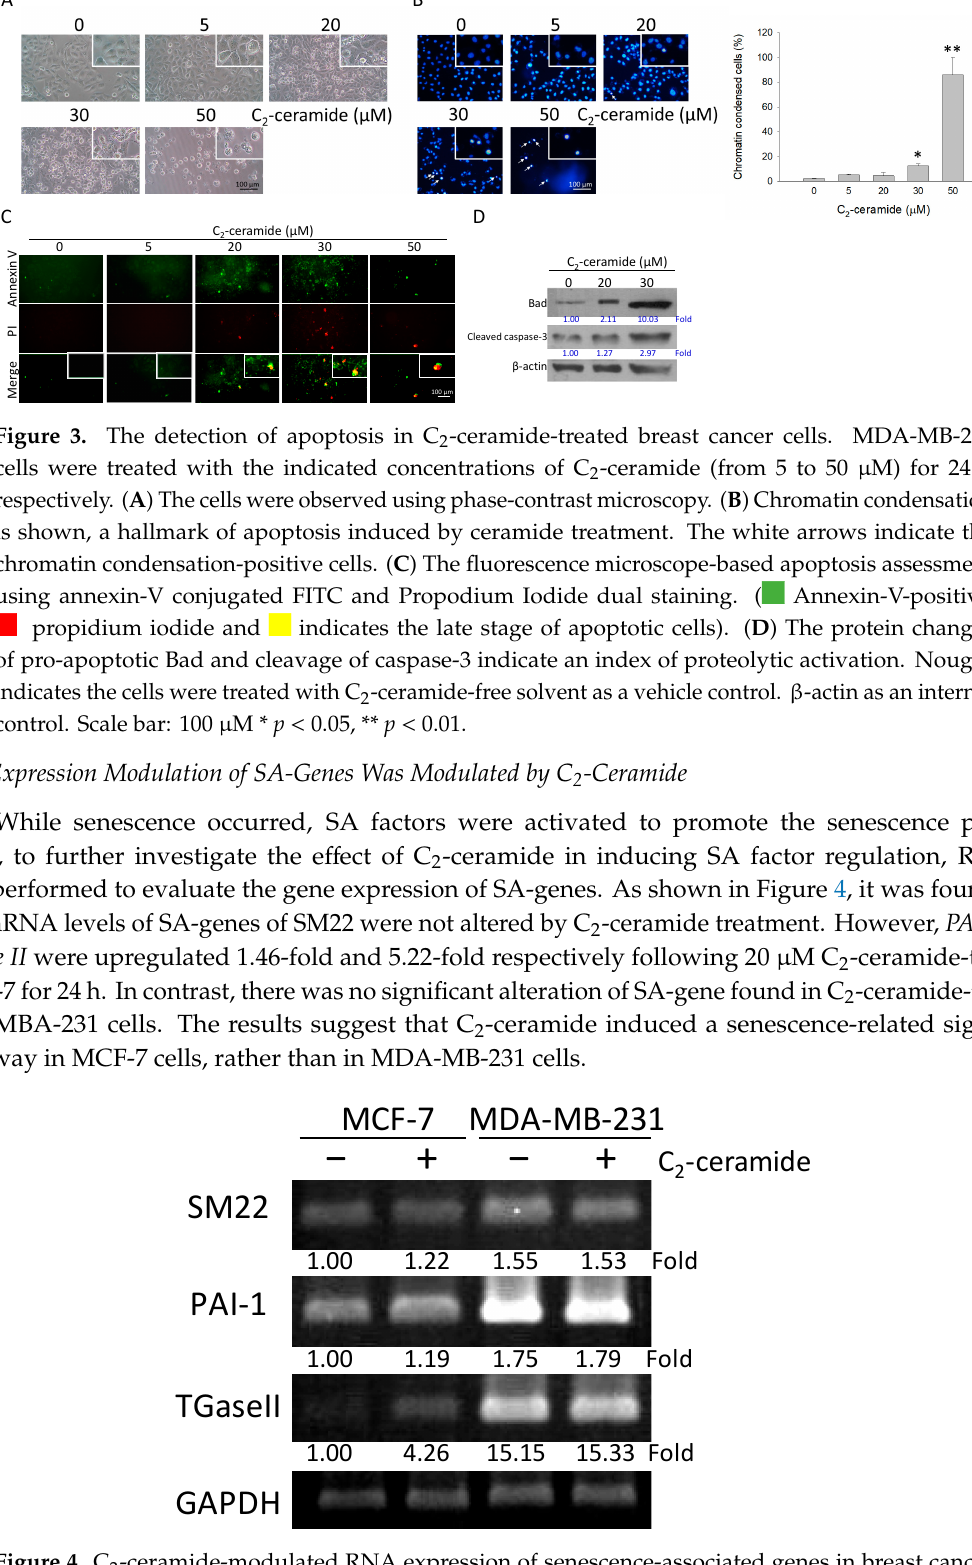
Figure 4. C 2 -ceramide-modulated RNA expression of senescence-associated genes in breast cancer cells. The two breast cancer MCF-7 and MDA-MB-231 cell lines treated with 20 µM C 2 -ceramide for 24 h respectively. SA-genes PAI-1 and TGaseII expression levels increased in MCF-7 cells but not in MDA-MB-231 cells. Glyceraldehyde-3-phosphate dehydrogenase (GAPDH) as an internal control. All fold changes were normalized by the level of internal control.